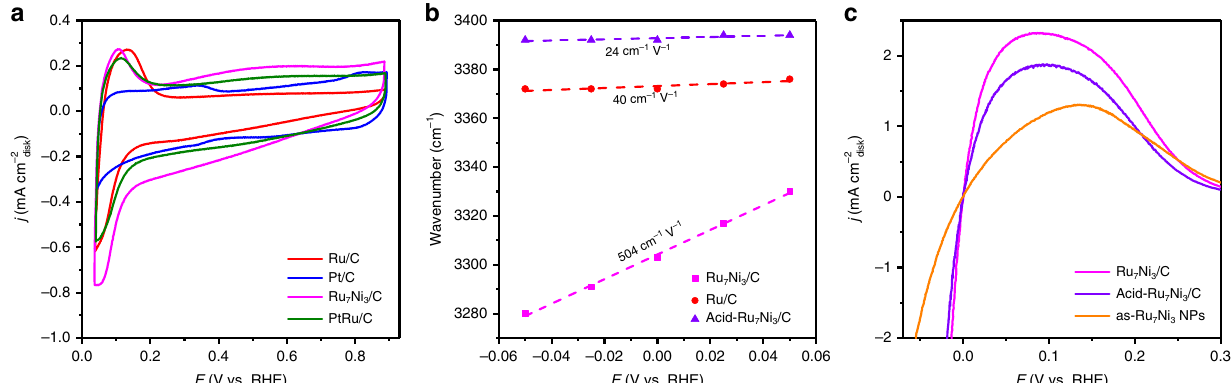
Fig. 5 Electrochemical analyses. a Cyclic voltammograms of Ru/C, Pt/C, PtRu/C, and Ru 7 Ni 3 /C in Ar-saturated 0.1 M KOH at a scan rate of 50mVs − 1 . All of the catalysts with a loading of 3.9 µ g PGM cm − 2 . b Changes of O − H stretching wavenumber of interfacial water for Ru/C, Ru 7 Ni 3 /C, and Acid-Ru 7 Ni 3 /C